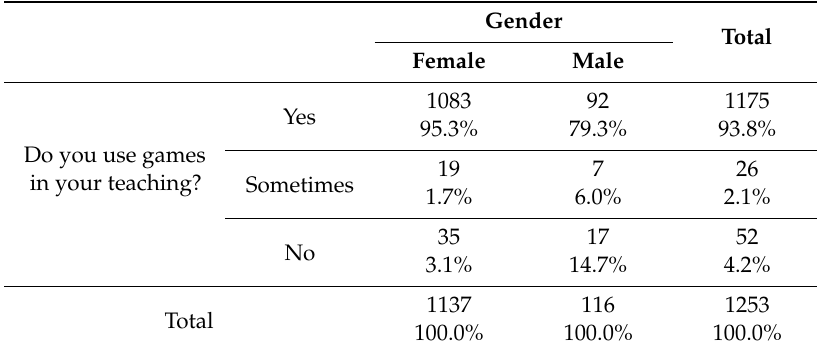
Table 2. Game use and gender di ff erences.